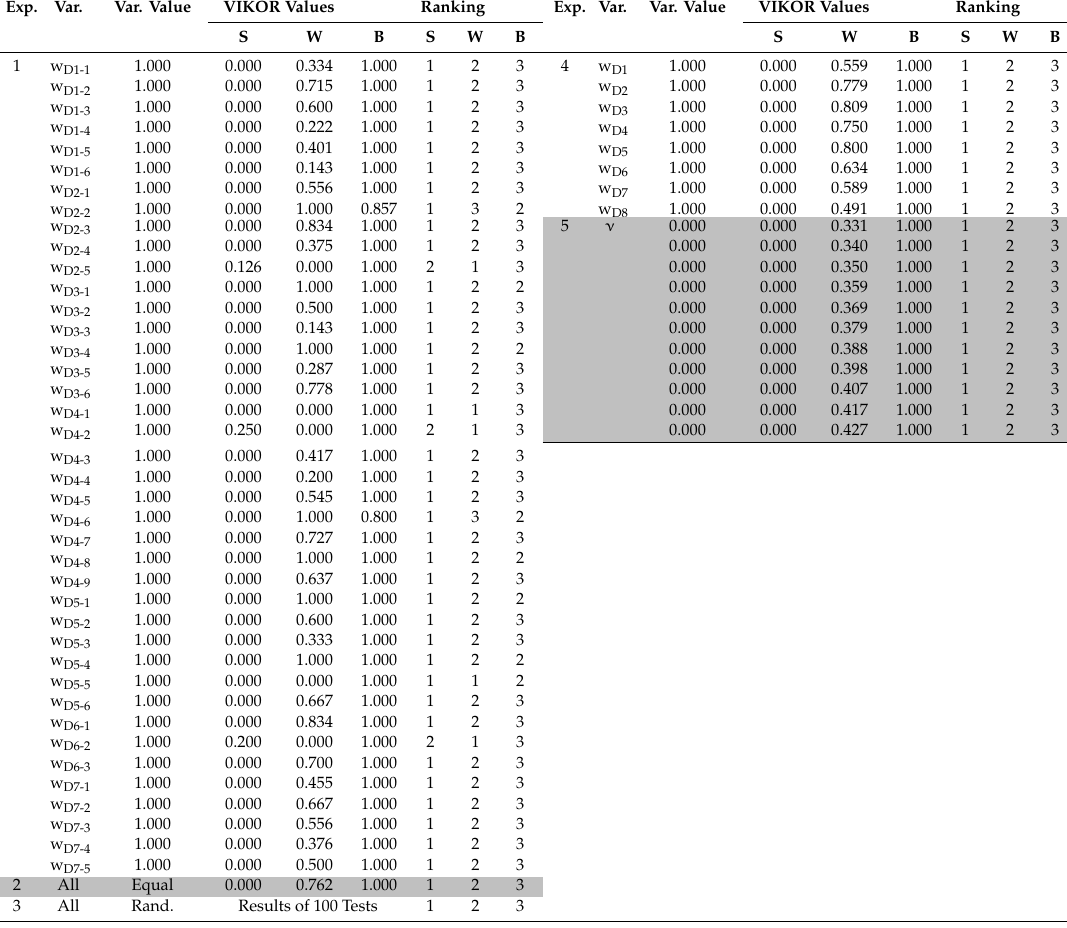
Table A4. Sensitivity Analysis of the Ranking Results by